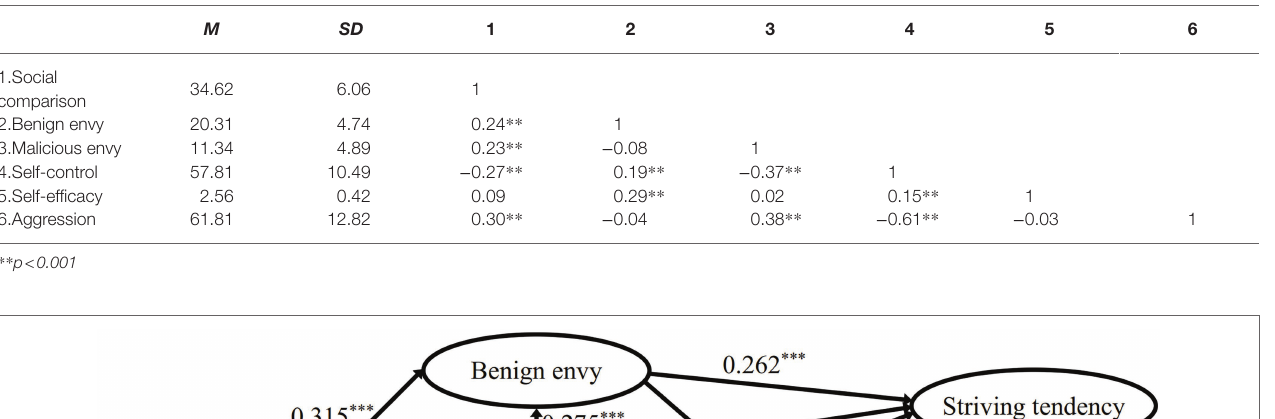
TABLE 1 | Descriptive statistics and correlation coefficients for each variable.